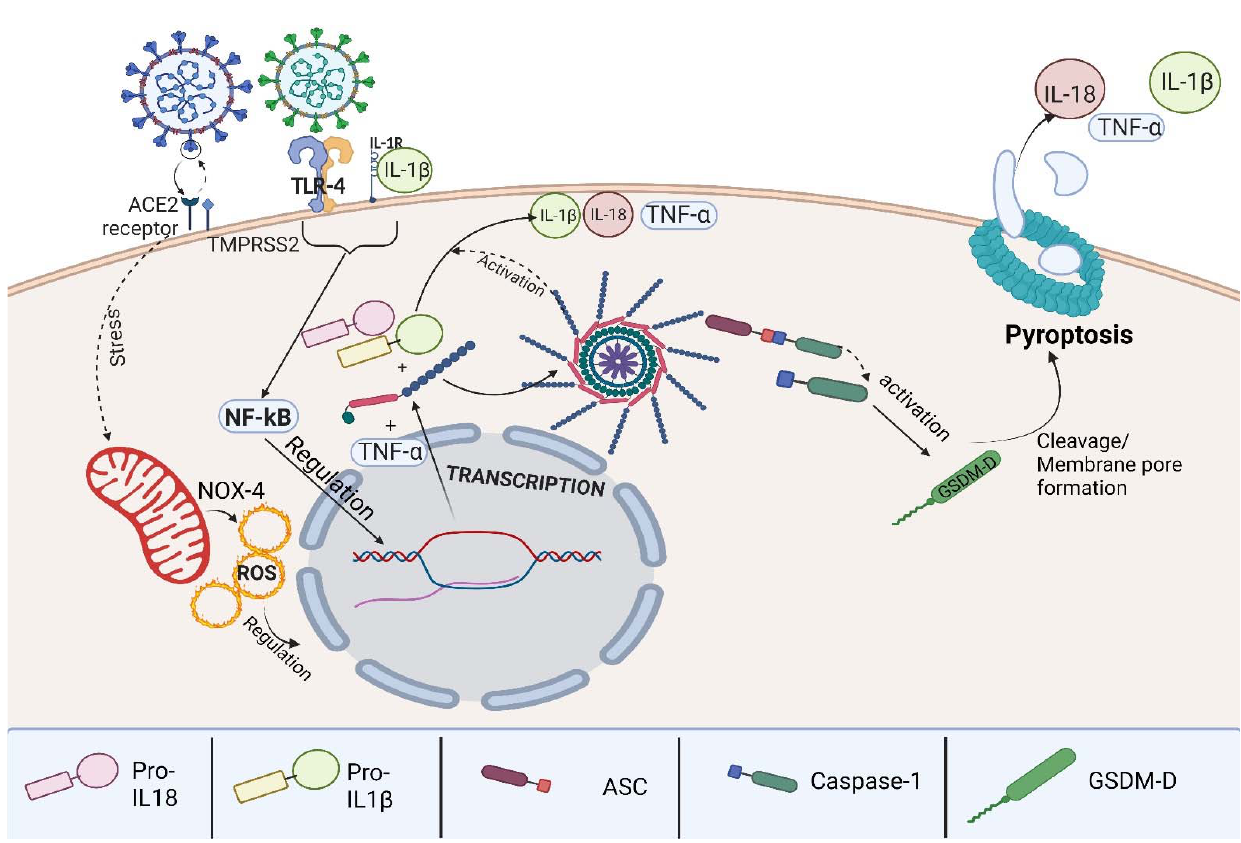
Figure 3. Graphical abstract demonstrating the viral infection stimulating ACE2 receptors and TLR4 receptors, modulating oxidative stress, and stimulating the NF- κ B pathway followed by protein transcription culminating in pro-IL-1 β , pro-IL-18, and TNF- α production. The process is then followed by NLRP-3 activation of pro-IL-1 β , pro-IL-18, CASP1 activation, and GSDM-D cleavage leading to pore membrane formation.